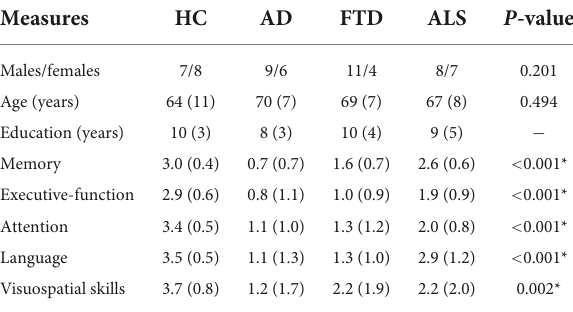
TABLE 1 Demographics, clinical, and neuropsychological data (means, SDs, and group